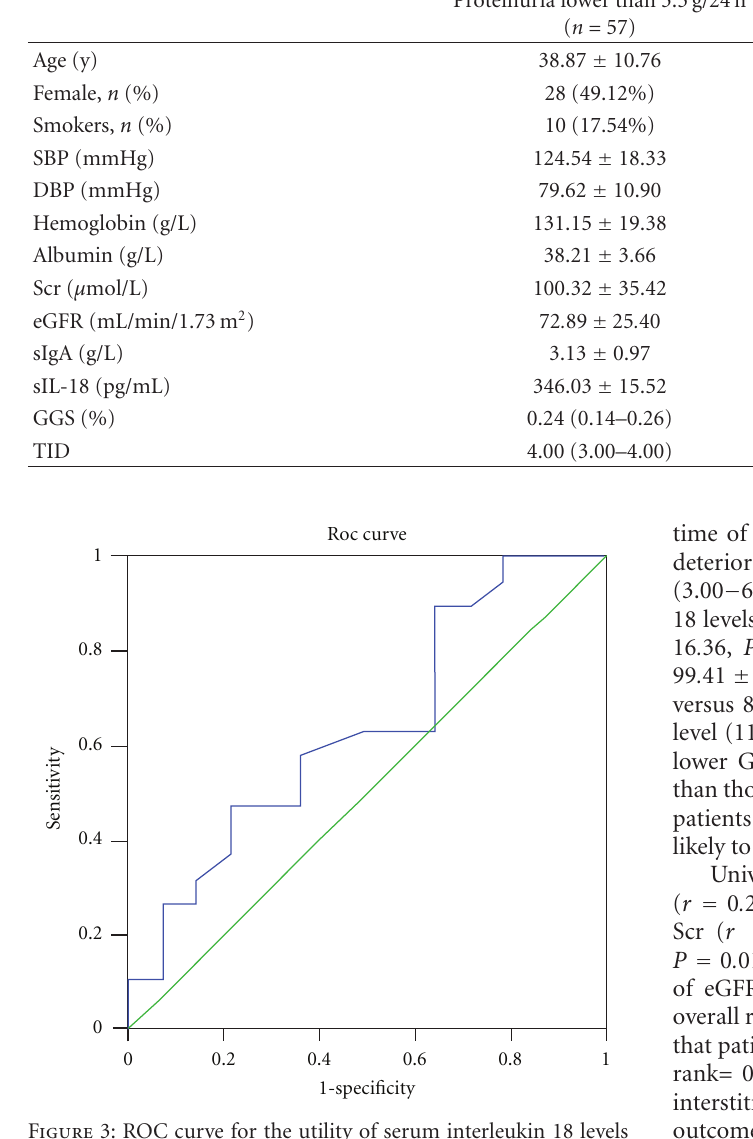
Figure 3: ROC curve for the utility of serum interleukin 18 levels for prediction of tubulo-interstitial damage in IgA nephropathy pa-